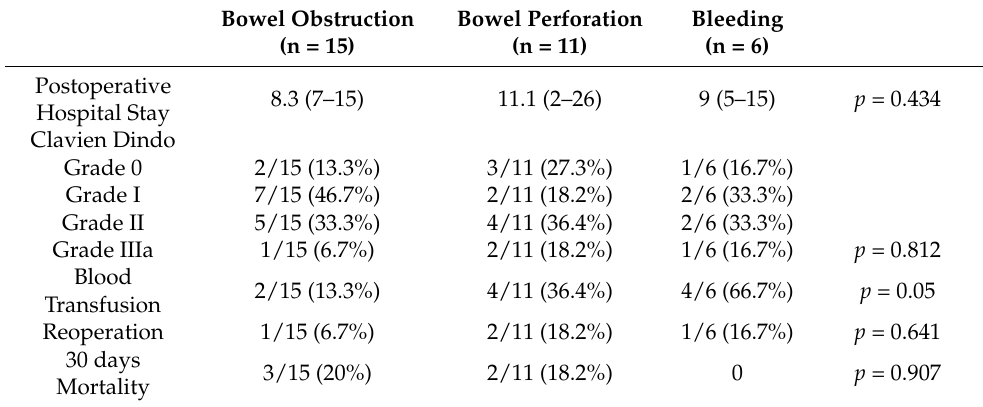
Table 2. Postsurgical data in different clinical pictures. Significance tests used are ANOVA and Chi-Square.